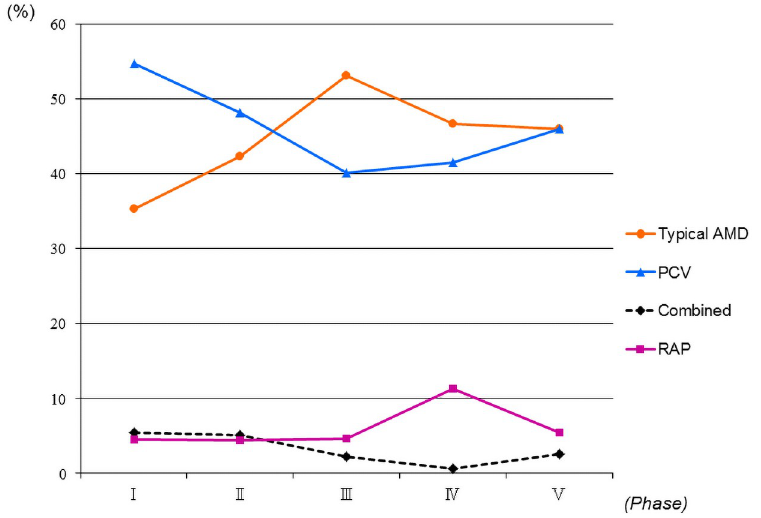
Fig 1. Changes in the prevalence rates of age-related macular degeneration (AMD) subtypes in 1,600 patients. Typical AMD increased from 35.3% in phase I to 46.0% in phase V and polypoidal choroidal vasculopathy (PCV) decreased from 54.7% in phase I to 46.0% in phase V. Phases I, II, III, IV, and V spanned, respectively, March 2003 to February 2005, March 2005 to February 2007, March 2007 to February 2009, March 2009 to February 2011 and March 2011 to February 2013. RAP = retinal angiomatous proliferation; combined = combined subtypes.